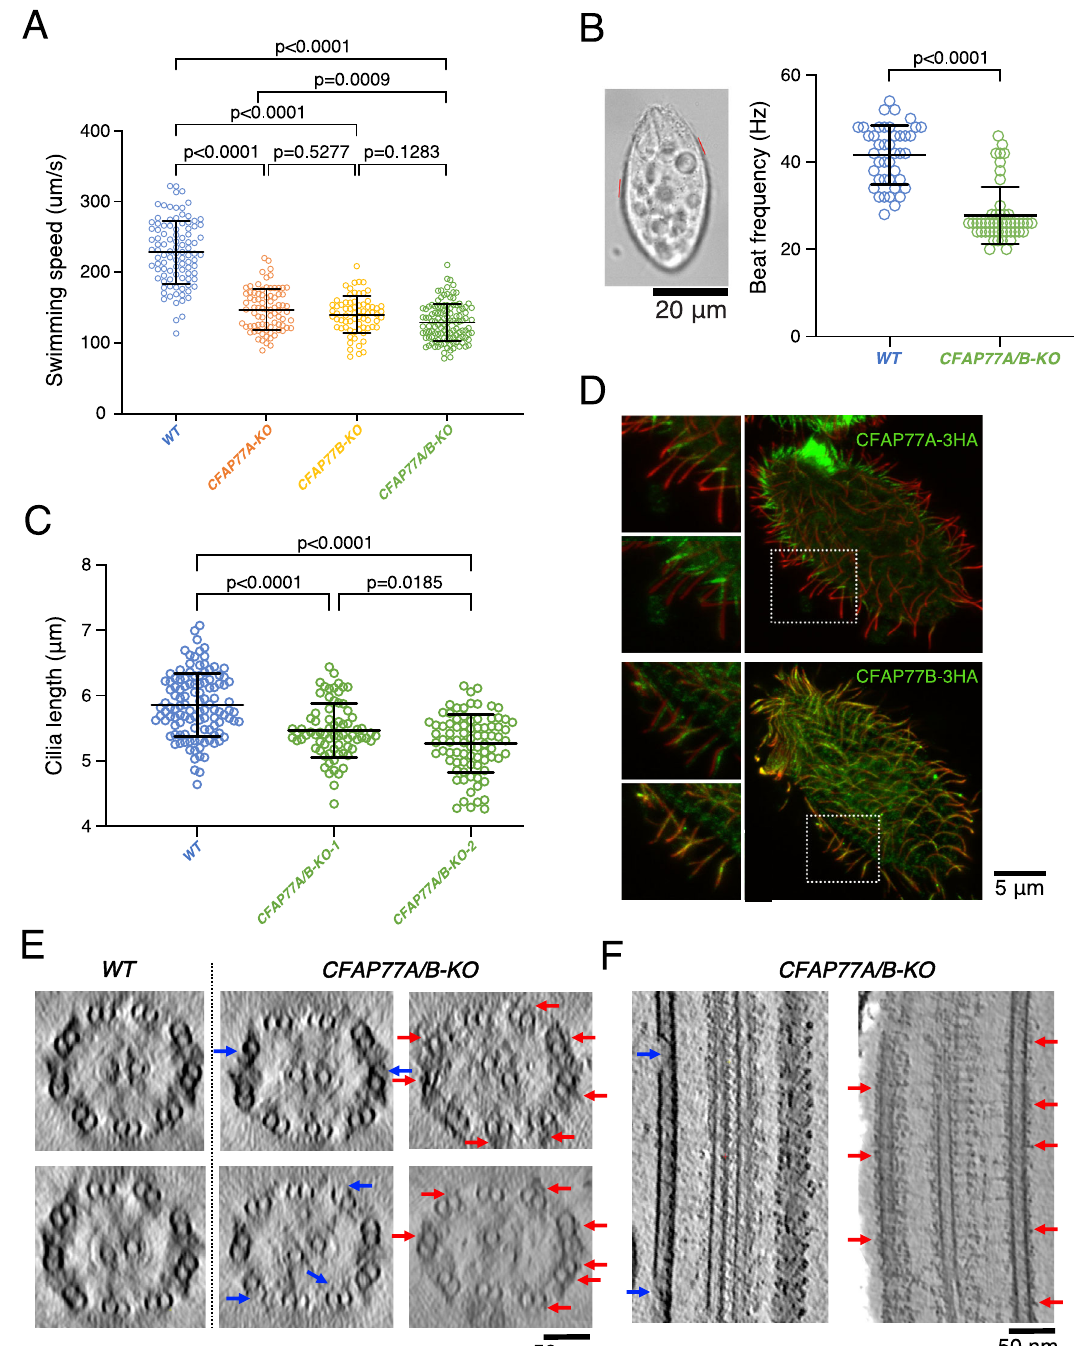
Fig. 6 | Knockout of CFAP77A/B caused mild defects in cilia. A Knockout of CFAP77A or CFAP77B , or both led up to 40% swimming speed reduction ( n =99 for WT, n =81 for CFAP77A-KO , n =70 for CFAP77B-KO , n =119 for CFAP77A/B-KO) . Statistical analyses were done with two-sided Tukey ’ s multiple comparisons tests. B Tetrahymena cells with marked exemplary positions (red lines) where cilia beat was analyzed in recorded swimming cells. Graphical representation of measure- ments of cilia beating frequency in WT and CFAP77A/B-KO mutants. ( n =42 cilia from12cellsforWT,n=48ciliafrom12cellsfor CFAP77A/B-KO ).Statisticalanalyses were done with a two-sided Mann-Whitney comparisons test. C Cilia length mea- surements of WT and CFAP77A/B-KO mutants. On average cilia length was: WT= 5.85 µ m (number of measured cilia, n =115), CFAP77A/B-KO clone 1=5.46 µ m